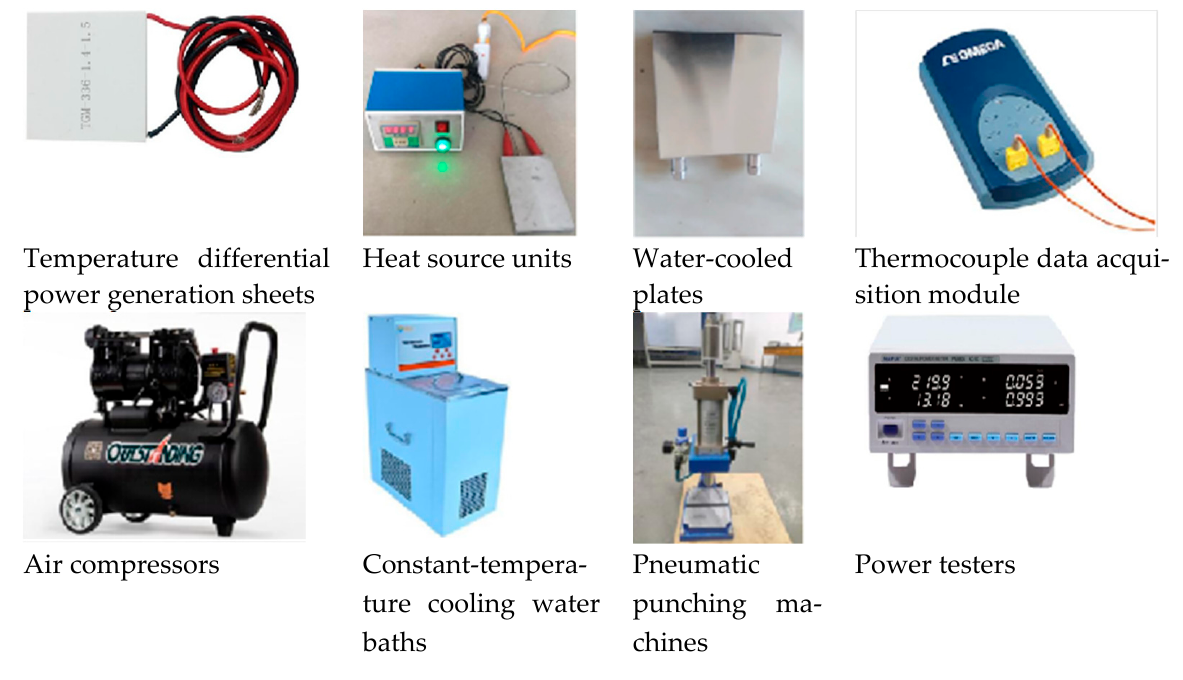
Figure 3. Experimental equipment.